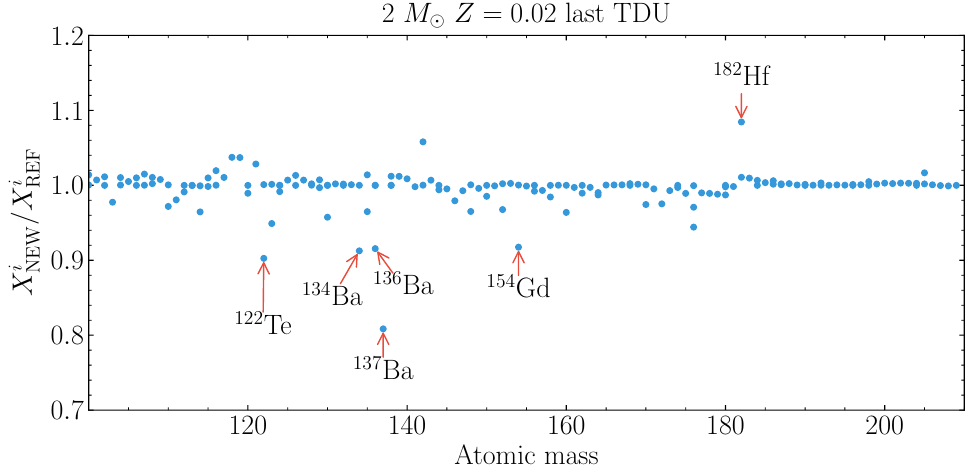
Figure 1. Ratio between the final heavy-isotopes surface distributions of the NEW case with respect to the REF case (see text for details) for an AGB model with initial mass M = 2 M Z = 0.02. Enlightened are isotopes whose variation is (cid:38)